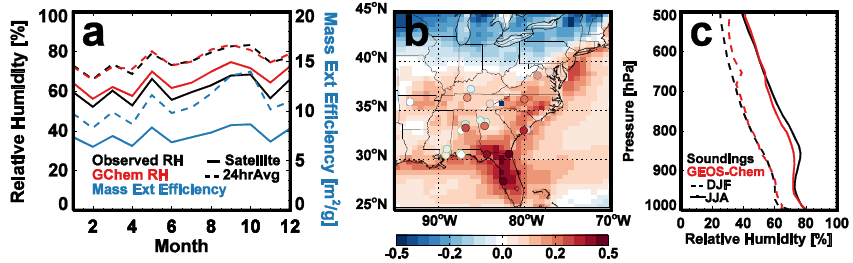
Figure 4. (a) Average 2009 monthly surface RH recorded at IMPROVE and SEARCH network nephelometer sites (black) using 24h averages (dashed line) and sampled to the afternoon overpass time (solid line). These are compared with values used in GEOS-Chem (red lines) sampled to observational site locations and converted to mass extinction efficiency values (for sulfate aerosols, blue lines). (b) Fractional increase in surface mass extinction efficiency of summer over winter simulated with GEOS-Chem and overlaid with values calculated from surface RH observed at IMPROVE nephelometer (blue circles), SEARCH (green circles) and sounding (black circles) sites for 2009. GEOS-Chem, SEARCH and IMPROVE data are sampled for the afternoon satellite overpass time (13:00–15:00LT) and the sounding data are averages from 00:00 and 12:00UTC. (c) Mean profile of RH measured at the 8 sounding sites (black lines) at 00:00 and 12:00UTC and the corresponding RH in GEOS-Chem (red line) sampled to the site locations and times for winter (dashed) and summer (solid) 2009.